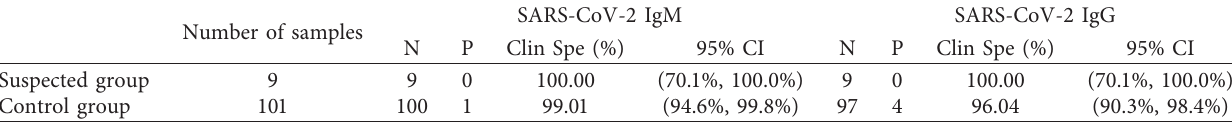
Table 1: Clinical specificity of SARS-CoV-2 IgM and SARS-CoV-2 IgG.